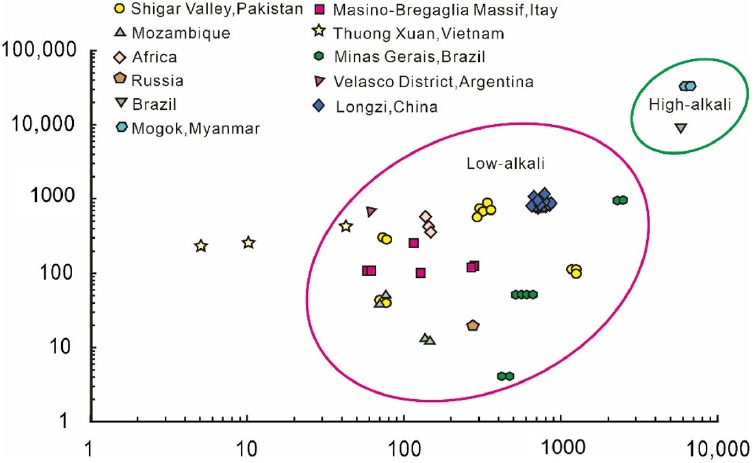
Figure 13. Chemical fingerprint diagram of the log–log plot of Li versus Cs. On the basis of the Li and Cs contents, beryls from different areas are classified as “high-alkali beryl” and “low-alkali beryl”. Other sources are [18,20–22,55].